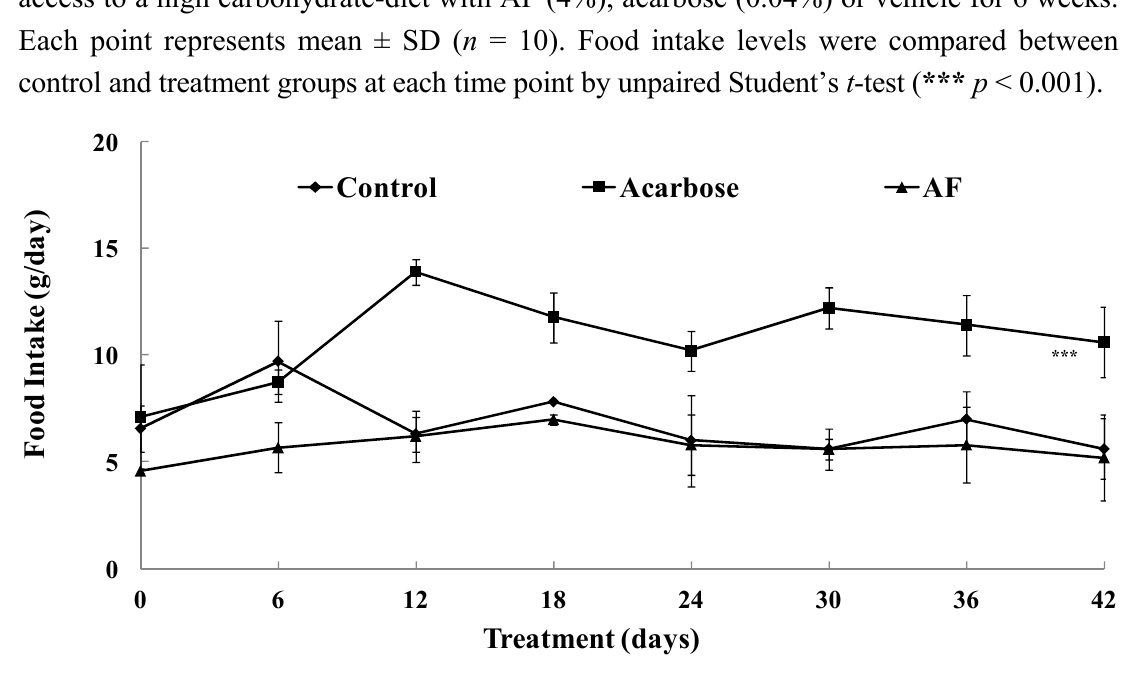
access to a high carbohydrate-diet with AF (4%), acarbose (0.04%) or vehicle for 6 weeks.